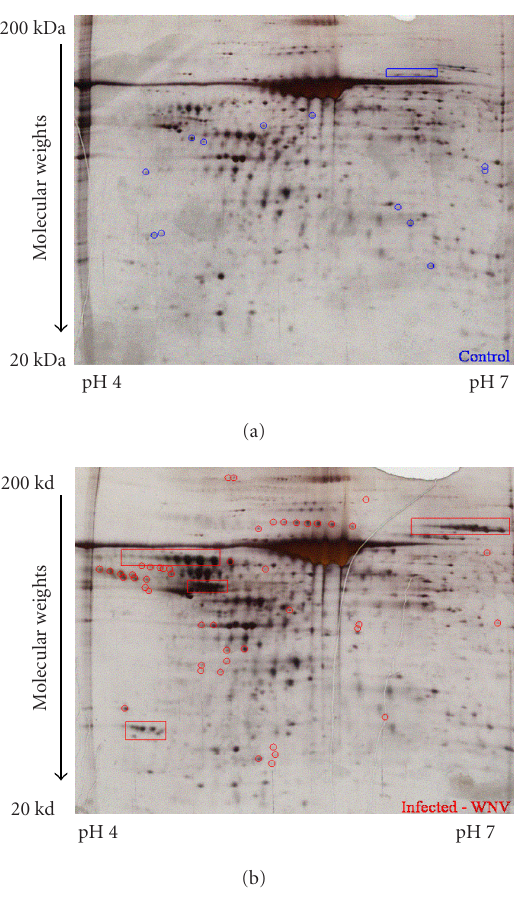
Figure 2. Silver-stained 2D gels in control and WNV-infected neurons. The pH range is 4–7 and the molecular weight markers represent from 200kd to 20kd (top to bottom). The spots circled in (b) (infected-WNV) represent the protein expression that is upregulated and the spots in (a) (control) show the proteins that have been downregulated in WNV infected neurons. from the central region of the spot, thereby